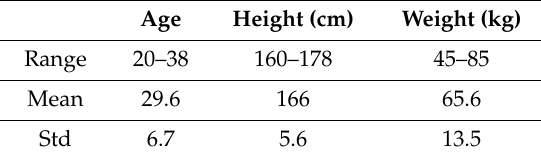
Figure 8. The experimental platform and sensor placement: ( a ) signal acquisition device, ( b ) the placements of the collection node, and ( c ) the process of data collection. Table 2. The statistics of subjects for the experiments.